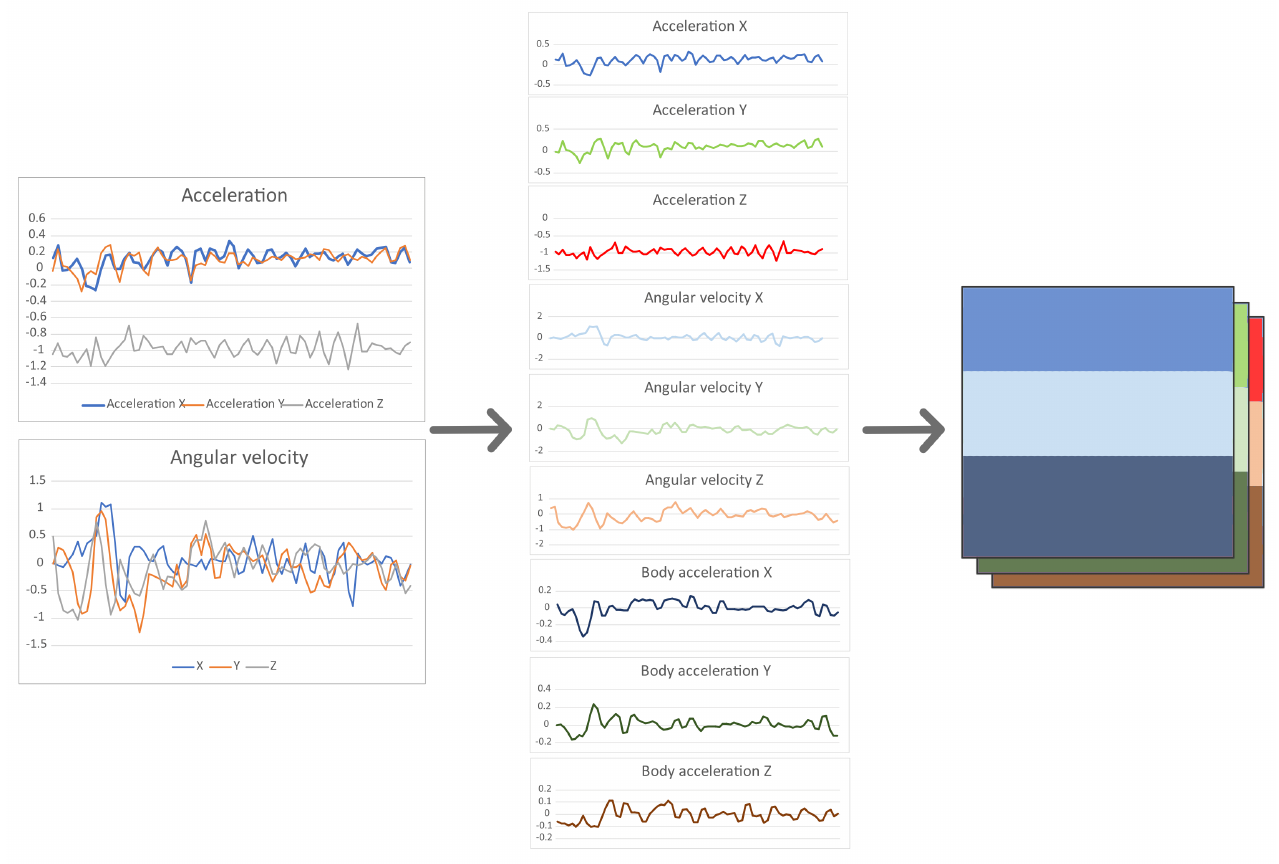
Figure 3. Converting the time-domain acceleration and angular velocity signals into 3D